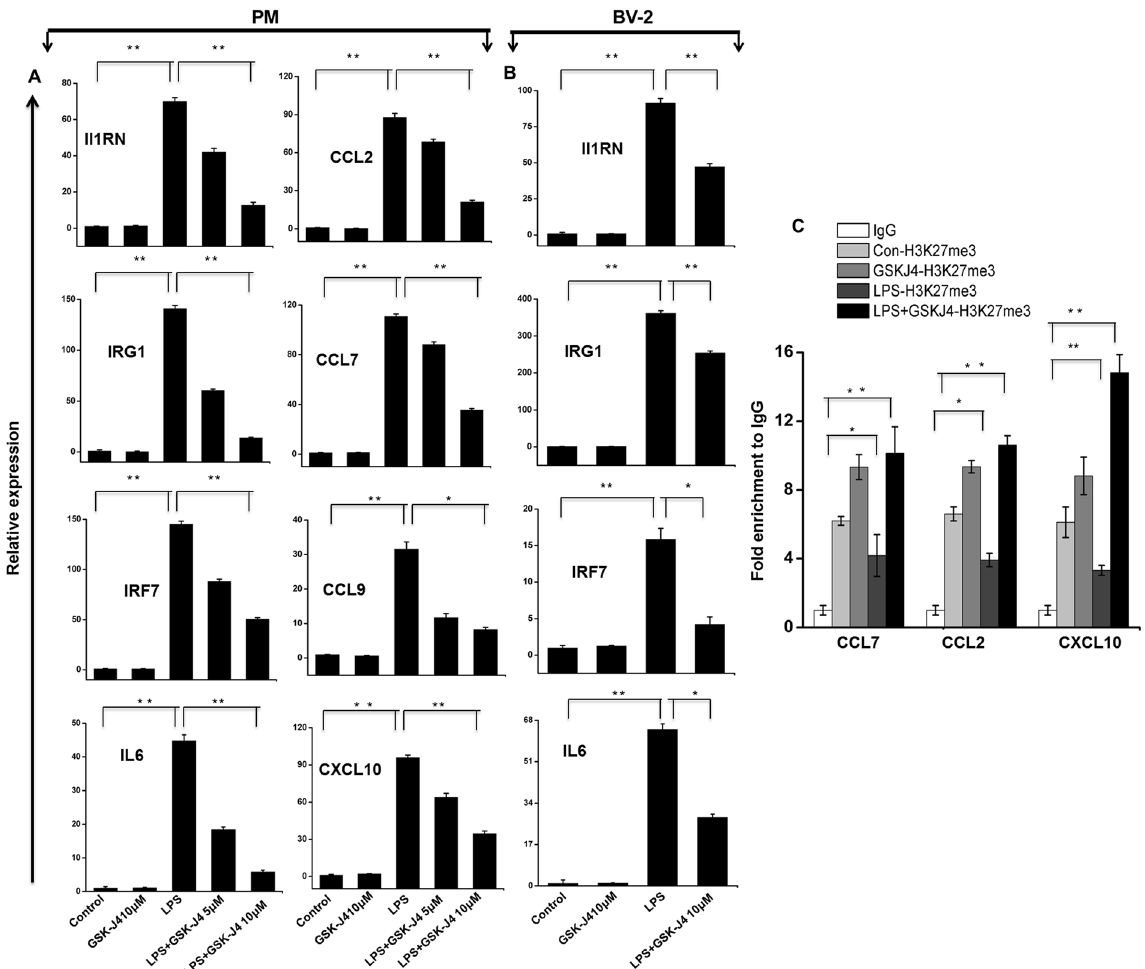
Figure 6. Validation of selected genes by quantitative reverse transcription-polymerase chain reaction in PM and BV-2 microglial cells. ( A , B ) The IL1RN, IRG1, IRF7, IL6, CCL2, CCL7, CCL9, and CXCL10 AND IL1RN, IRG1, IRF7, and IL6 genes were significantly down-regulated in the GSK-J4-treated PM and BV-2 microglial cells, respectively. Gene expression was normalized to the GAPDH transcript levels. * P < 0.01 and ** P < 0.001 compared with the control. The data represent three independent biological experiments. ( C ) ChIP assay to determine the presence of H3K27me3 at selected genes. The ChIP-enriched samples were analyzed using quantitative PCR with selected gene primers. The H3K27me3 levels were decreased following LPS exposure while an induced presence of H3K27me3 was shown at the promoters of the CCL2, CCL7, and CXCL10 genes in GSK-J4-treated BV-2 microglial cells. The graphs represent the mean fold values of enrichment relative to IgG control from three independent experiments. * P < 0.01 and ** P < 0.001 compared with the